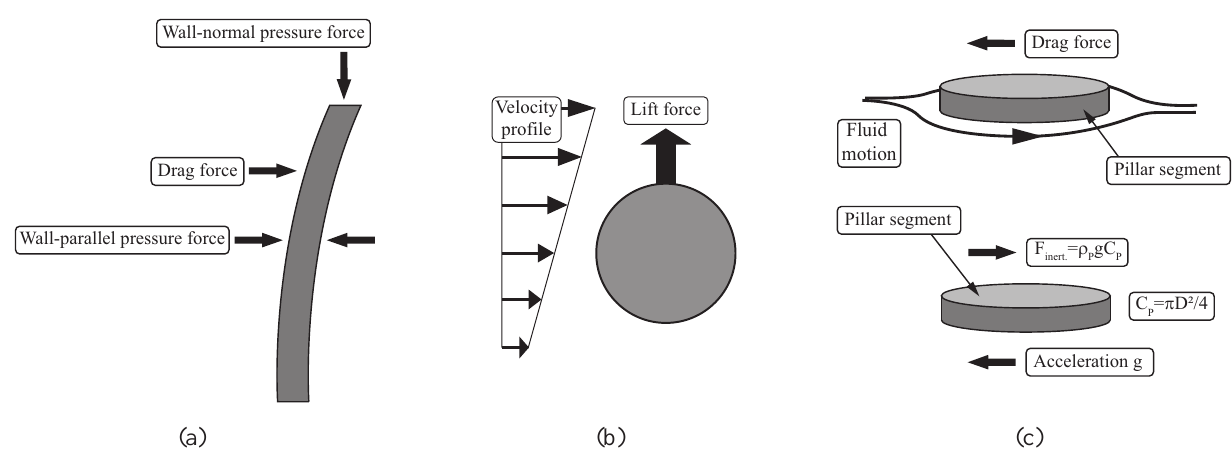
Figure 7. ( a ) Overview of possible pressure and Stokes/Oseen drag force contributions. ( b ) Lift force induced by a shear flow over a segment of the micro-pillar sensor. ( c ) Effect of fluid induced drag and inertial forces on a segment of the micro-pillar